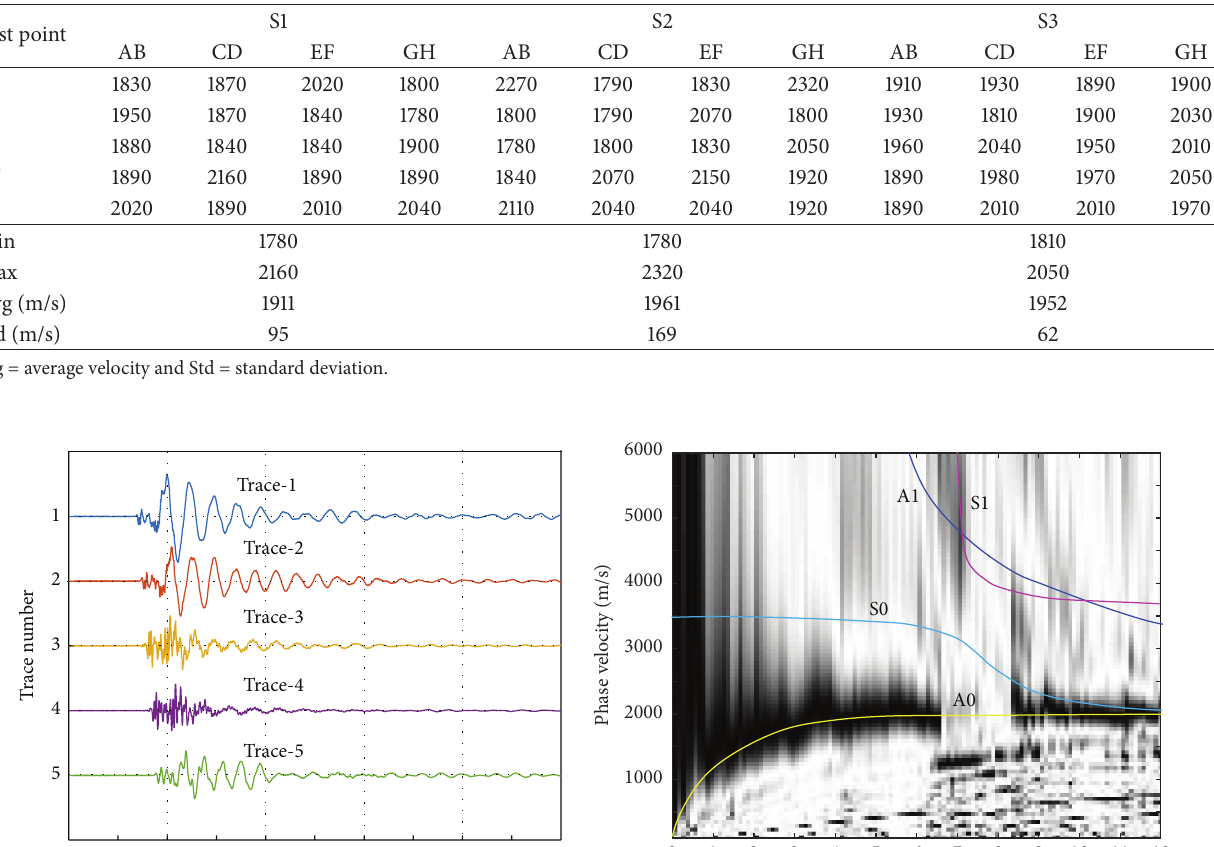
Table 3: S-wave velocities (m/s) at test grid points in slabs S1, S2, and S3.